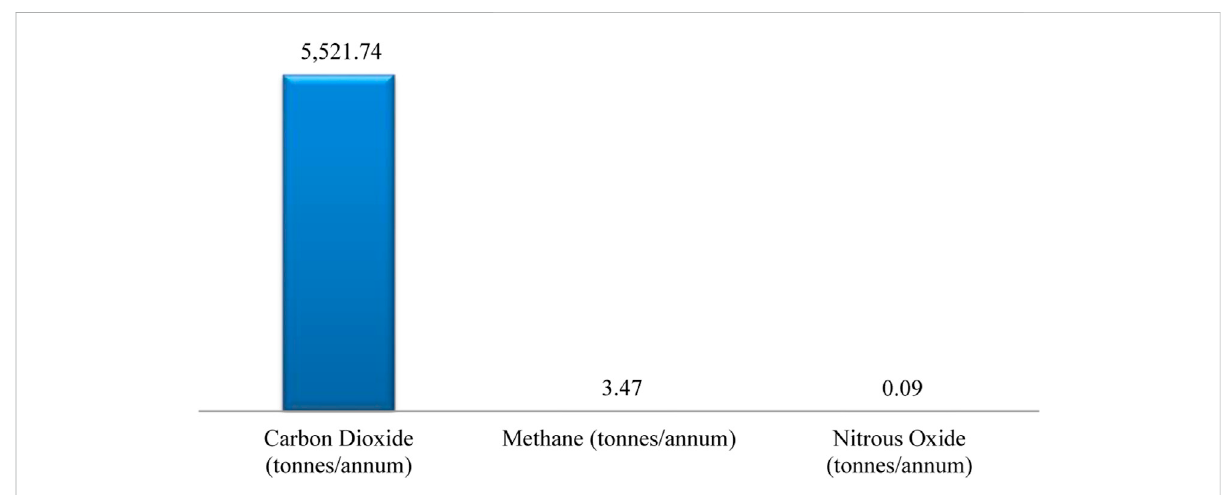
FIGURE 10 Annual GHG emissions load (tonnes/annum) from harbour crafts of